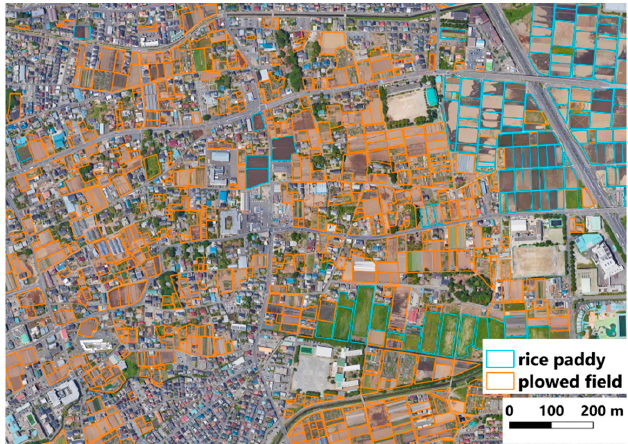
Figure 1. Farmland parcels (HUDE polygon).